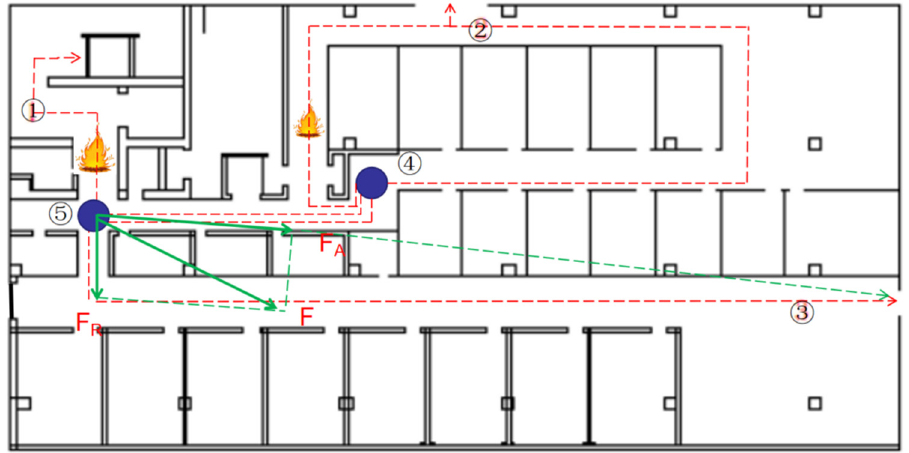
Figure 9. Single cell evacuation diagram: is the fire point; ① , ② , and ③ are escape exits, and the position of a single pedestrian moves from ④ to ⑤ ; F A is the attraction; F R is the resistance to judge the fire and obstacles; and F represents working together to effectively find a reasonable exit.